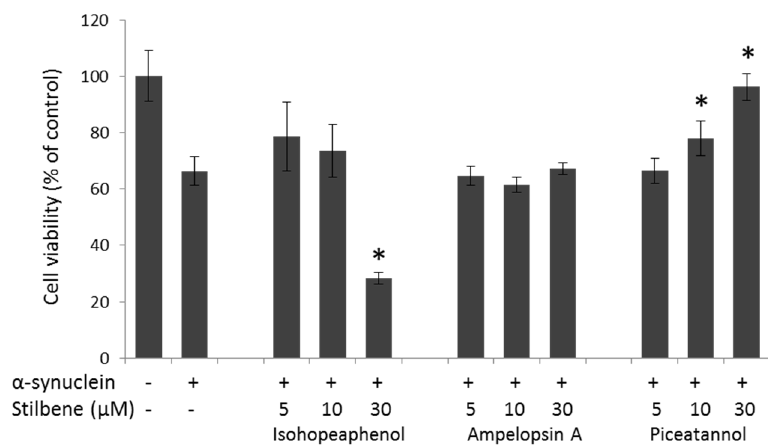
Figure 6. Cytotoxicity of α -synuclein aggregates. Cell viability was determined by using the MTT reduction assay. Results are expressed as the percentage of cell viability compared with the untreated control cells. The addition of 500 nM of aggregated α -synuclein alone on PC12 cells caused a significant loss of viability. Effects of stilbenes on cell viability were studied after the addition of 5 µ M, 10 µ M, and 30 µ M of isohopeaphenol, ampelopsin A, and piceatannol. Results are expressed as mean ± SD * p < 0.05 versus α‐ synuclein alone.